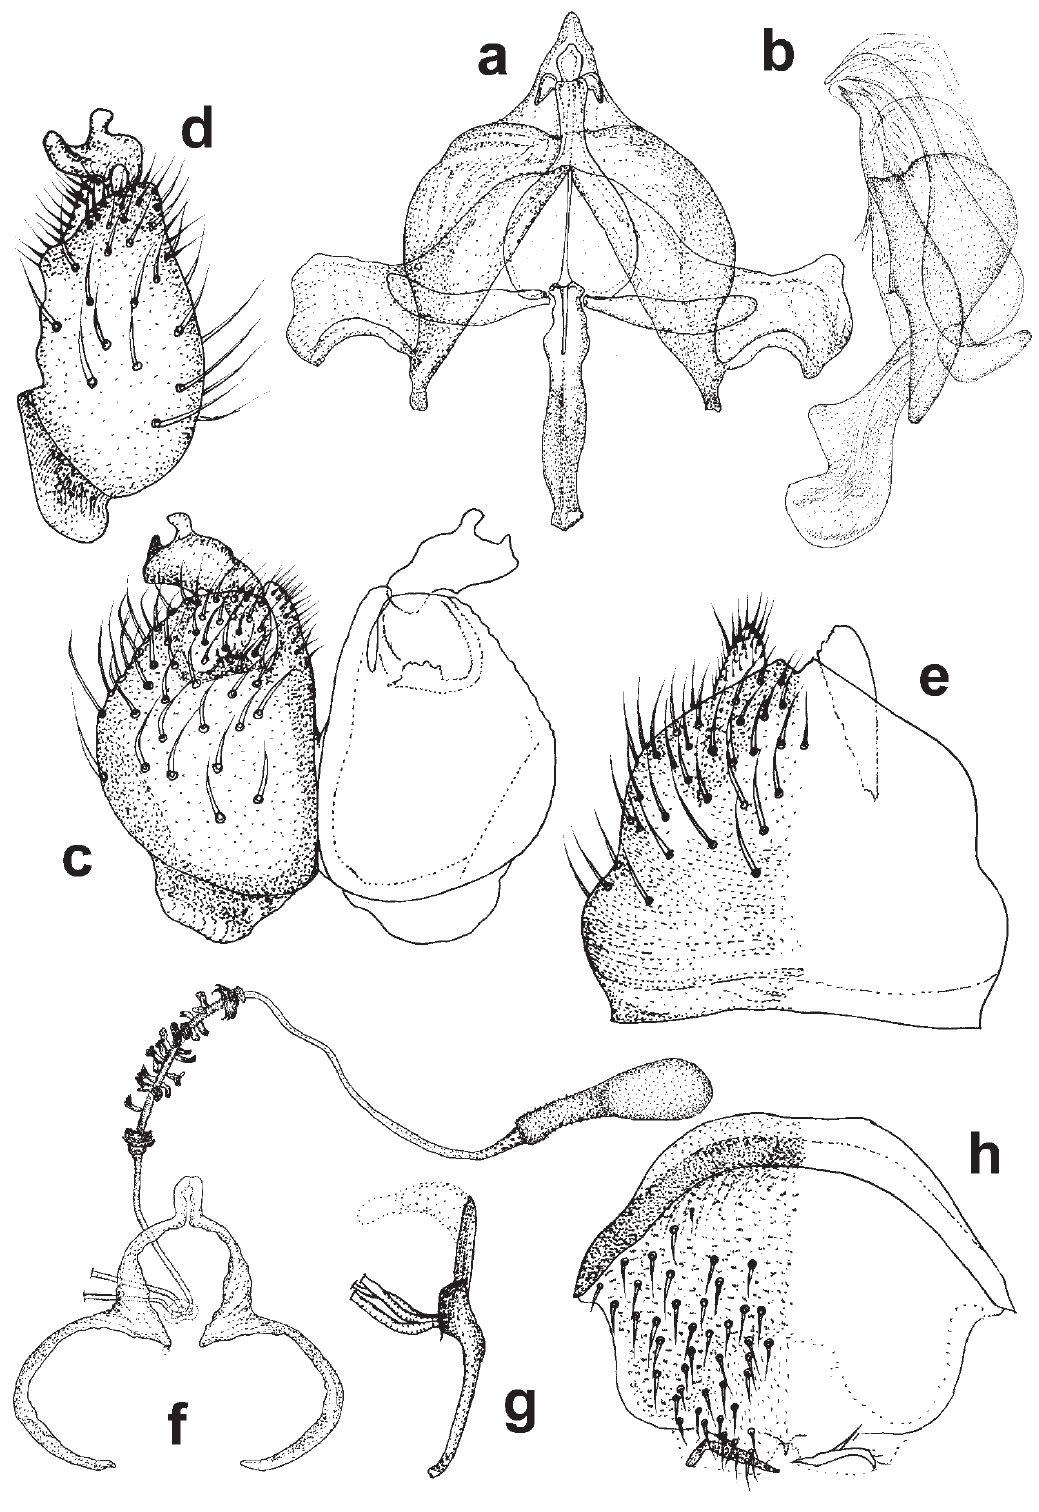
Fig. 46. Protypusia flavipalpis gen. et sp. nov. a . Epiphallic complex ventral. b . Epiphallic complex lateral. c . Gonocoxite ventral. d . Gonocoxite lateral. e . Epandrium dorsal. f . Female genitalia ventral. g . Female genitalia lateral. h . Female sternite 8